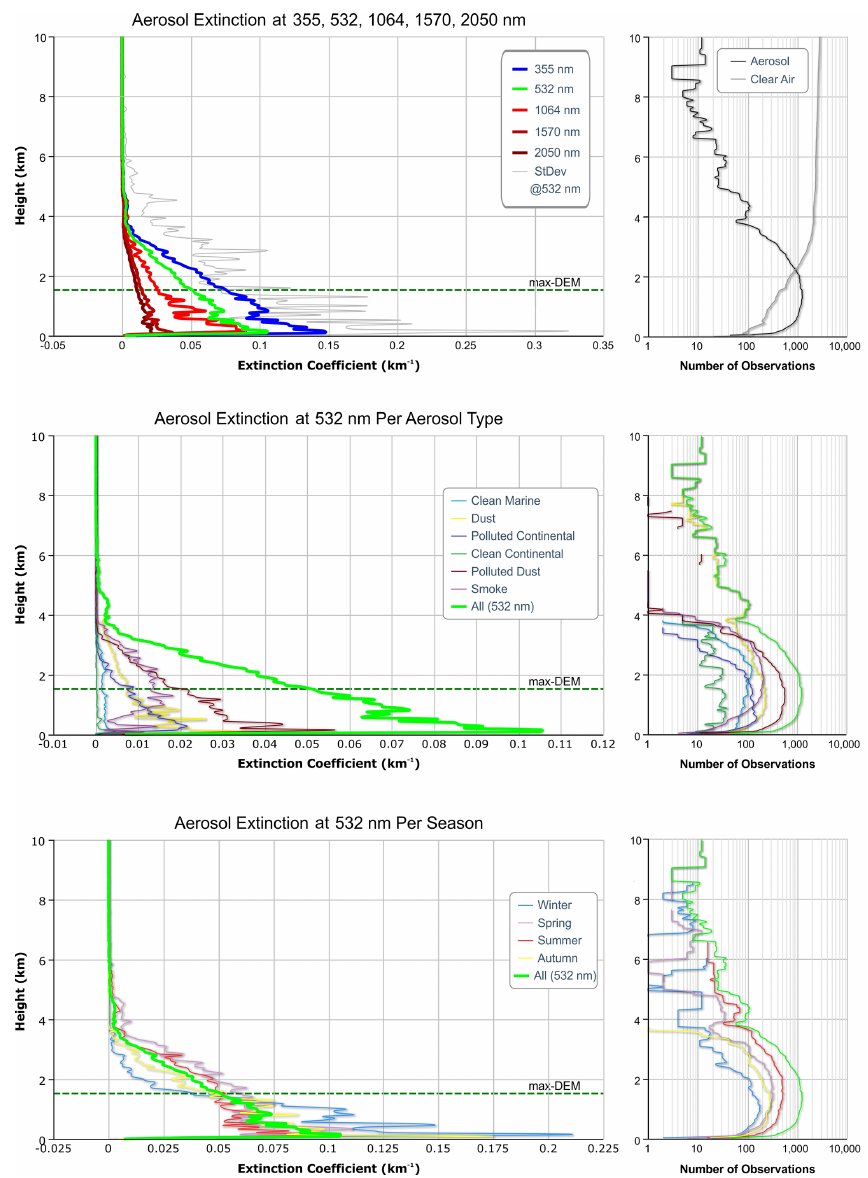
Figure 10. LIVAS aerosol extinction products. Upper panel: vertical distribution of the averaged aerosol extinction coefficient at 355, 532, 1064, 1570, and 2050nm (left), number of observations used in averaging (right). Middle panel: vertical distribution of the averaged aerosol extinction coefficient per aerosol type (left), number of observations used in averaging (right). Lower panel: vertical distribution of the averaged aerosol extinction coefficient per season (left), number of observations used in averaging